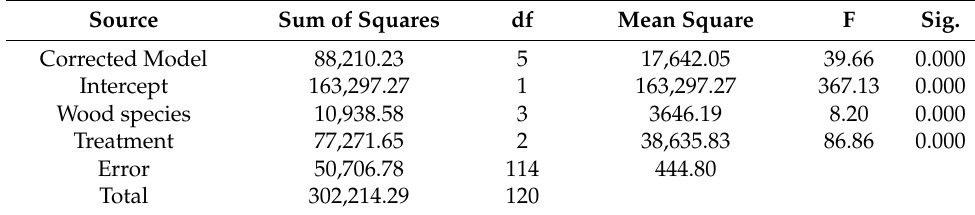
Table 11. Variance analysis of weight loss percentage.